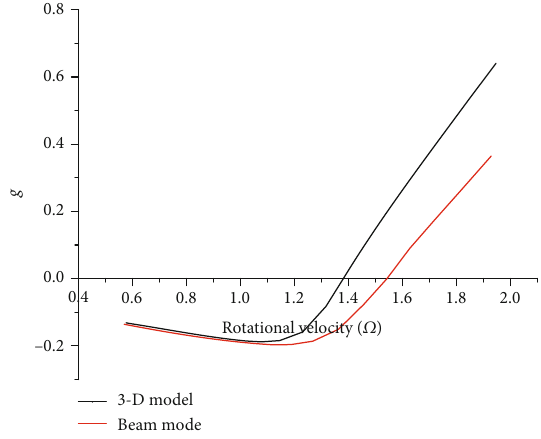
Figure 10: V-g diagram of the blade ( AR = 18 : 07 ).